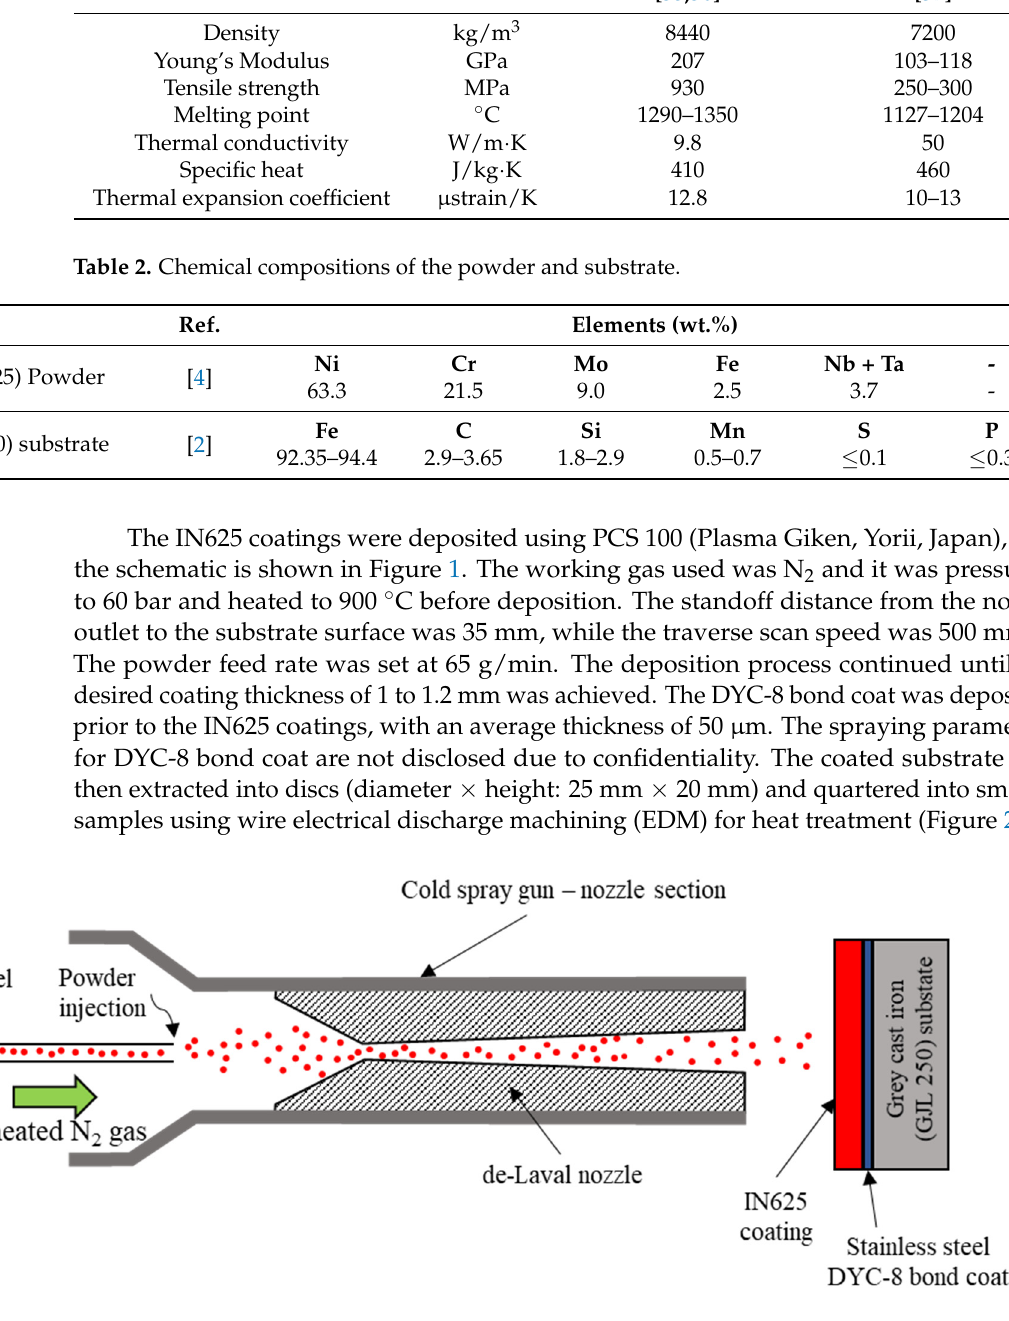
Figure 2. Cold sprayed sample ( a ) extracted from plate and ( b ) quartered using wire EDM process. 2.2. Heat Treatment Process The samples were ground and degreased to remove contaminants, and subsequently heat-treated at various temperatures for different holding durations according to Table 3, using an air furnace (Lenton UAF 14, Hope, UK). The furnace was preheated to the in- tended temperature before inserting the samples into it. Upon completing the heat treat- ment, the samples were left to cool at room temperature (25 °C). Table 3. Heat treatment of cold sprayed IN625 coating on grey cast iron (GJL250) substrate. Sample ID (Temperature-Duration)